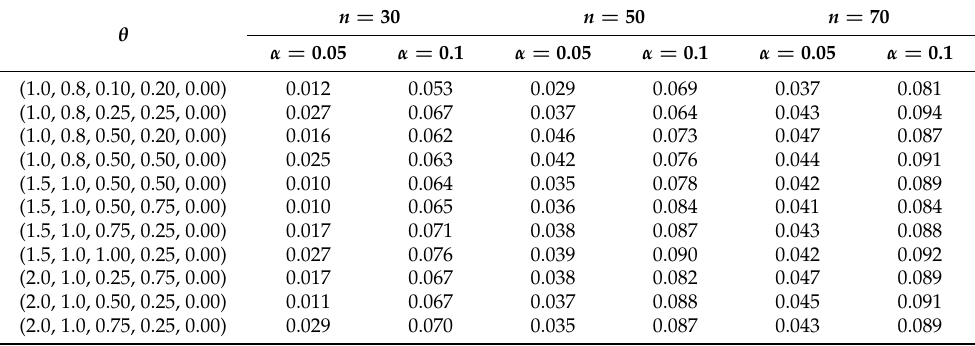
Table 1. Simulation results for the probability of type I error for a 1 = 0 and a 2 = 0.